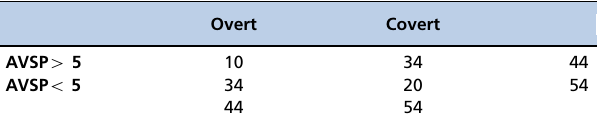
Table 3 - Hypofunction (AVSP o 5 degrees) and the presence of overt and covert saccades.